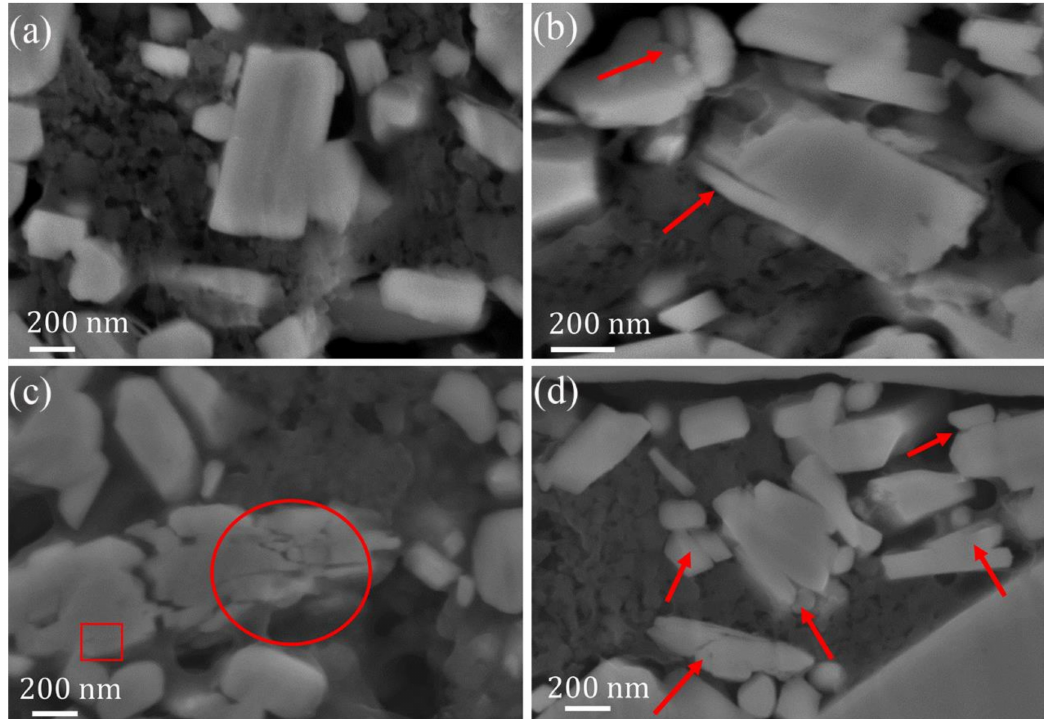
Figure 4. Cross-sectional SEM images of the polished electrode samples: ( a ) Pristine electrode; ( b ) after 10 cycles; ( c ) after 60 cycles, and ( d ) after 100 cycles. The cracks and fragments are marked by red arrows and